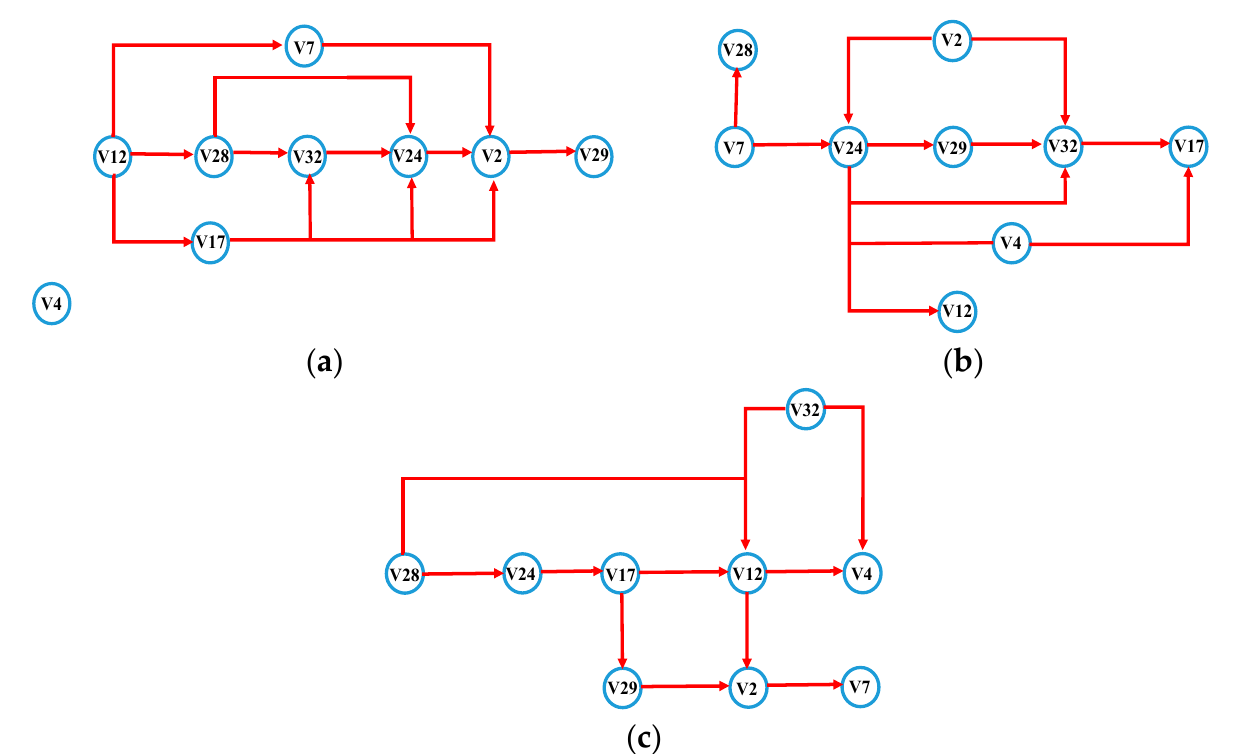
Figure 14. Information flow diagram of the three movement conditions: ( a ) appropriate angle, ( b ) excessive angle, ( c ) angle